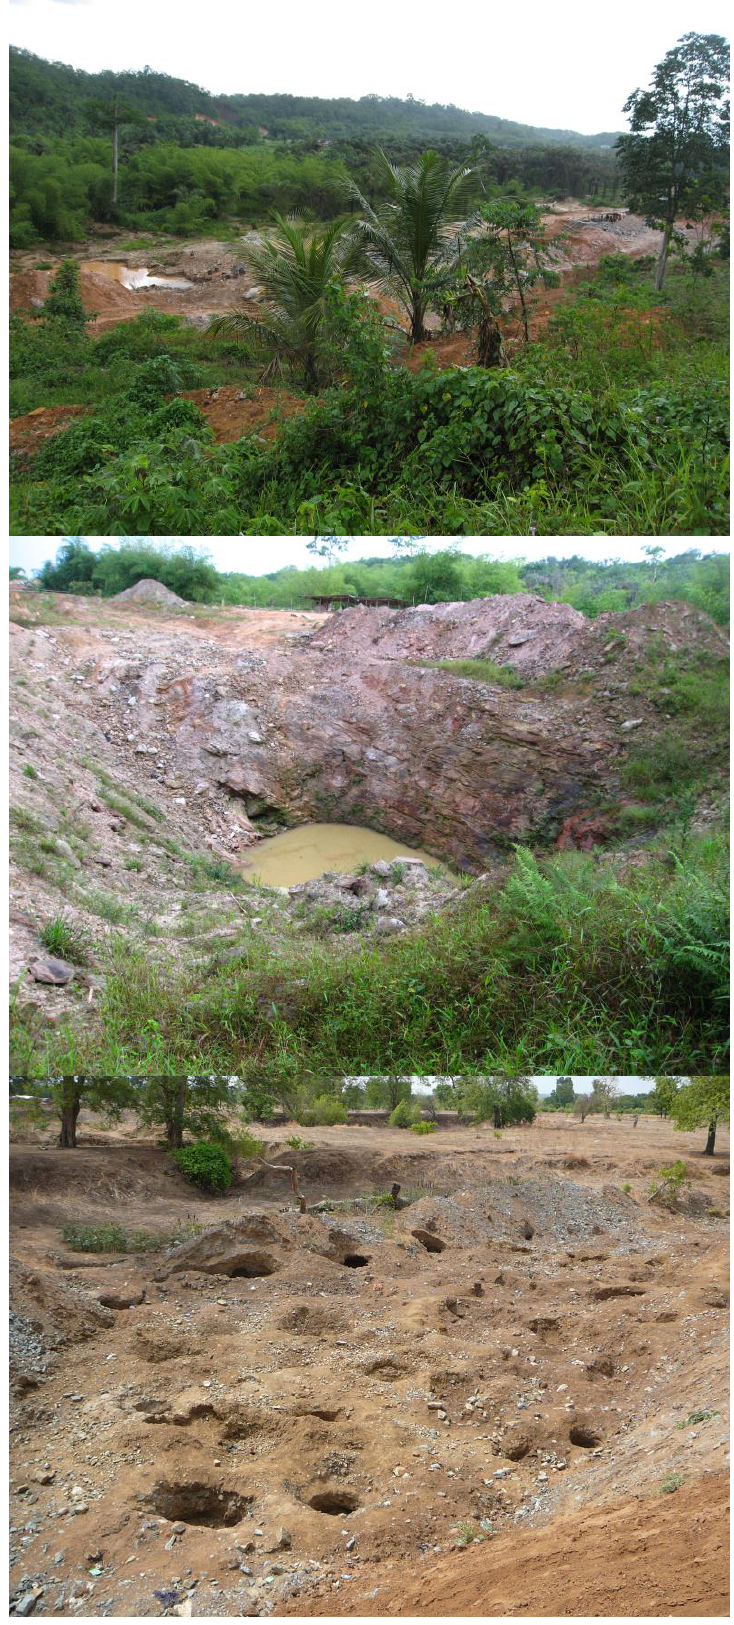
Figure 12 . Images of land disturbances at ASGM sites in Tarkwa, Western Region (upper and middle photos) and the Talensi District, Upper East Region (bottom